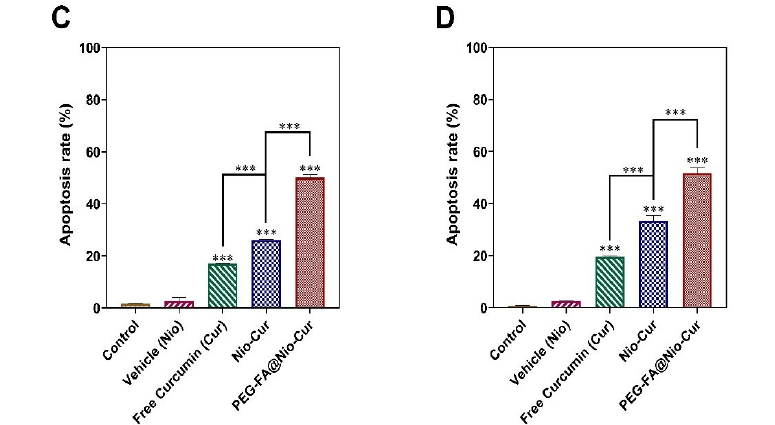
Figure 4. The effects of control, Cur, and different niosome formulations on vehicle (Nio), Nio-Cur and PEG-FA@Nio-Cur of MCF7 and 4T1 breast cancer cells that had undergone 48 h of treatment are shown in ( A , B ), respectively. Means and standard deviations are represented by the data ( n = 3). For all charts, ***: p < 0.001; **: p < 0.01; *: p < 0.05. Flow cytometric analysis of ( C ) MCF7 and ( D ) 4T1 cells after treatment with IC50 concentration of vehicle (Nio), Cur, Nio-Cur, and PEG-FA@Nio- Cur formulations. Nonmalignant breast epithelial cell line MCF10A did not show any statistically significant alterations in survival after being exposed to serially diluted empty niosomes at various concentration levels.